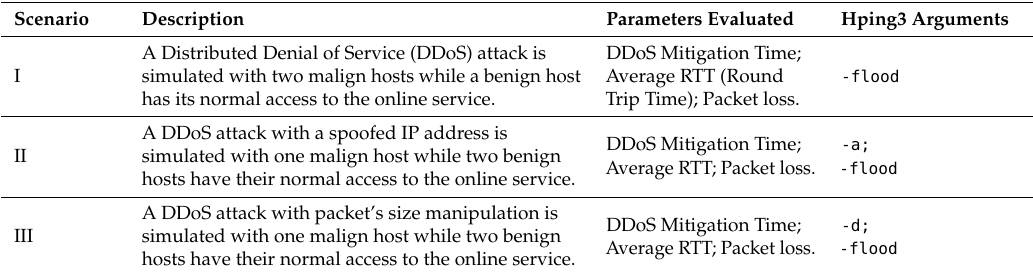
Table 2. Test Scenarios Summary.